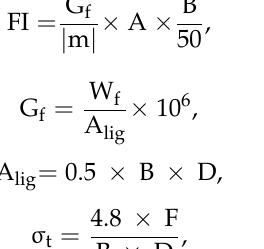
Figure 4. ( a ) UTM-25 universal testing system; ( b ) Bend test fixture; ( c ) Specimen under SCB test. where FI denotes the flexibility index, G f (J/m 2 ) denotes the fracture energy, and m denotes The FI is defined by Equation (1) using the parameters obtained from the load – dis- the slope at the inflection point on the load–displacement curve after the peak point, as placement curve of the SCB test, as shown in Figure 5. A simple correction factor was shown in Figure 5. A = 0.01 for unit conversion and scaling, B (mm) denotes the specimen established to eliminate the effect of thickness variations on the FI, as expressed in Equa- thickness, and W f (J) denotes the work of fracture, calculated as the area under the load– tion (1) [41]. Considered as the evaluation index, the tensile strength ( σ ) of the un-notched t displacement curve using analytical integration. The pre-peak and post-peak load portions SCB specimen geometry was determined using Equation (4) as follows [14]: of the curve were fitted using a polynomial function and an exponential-based